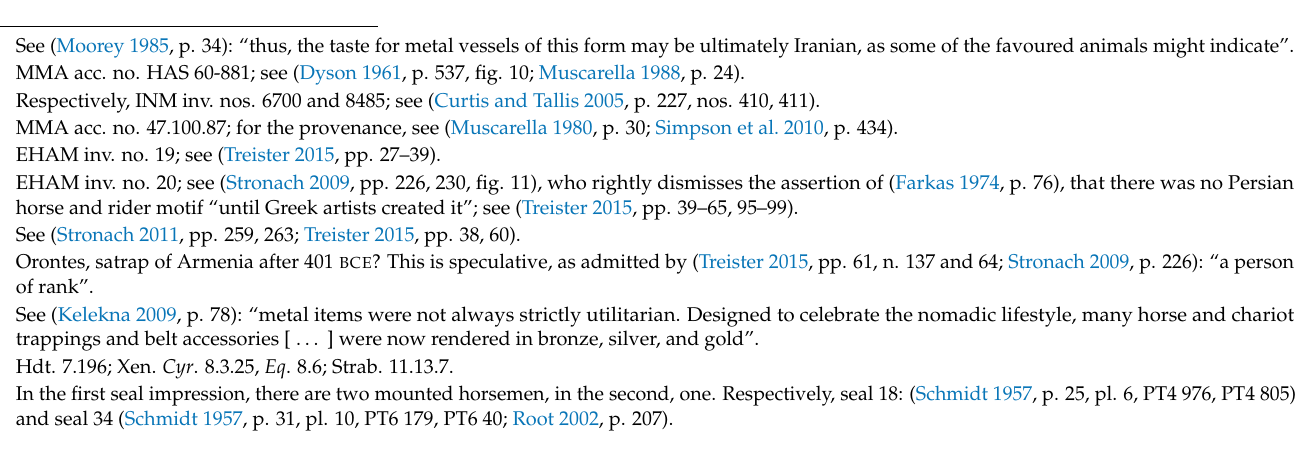
Figure 7. Drinking vessel in shape of horse protome (EHAM inv. no. 19); rhyton, silver; Erebuni, Armenia; (post?) Achaemenid, ca. 4th cent. BCE [image courtesy of the Erebuni Historical and Ar- chaeological Museum-Reserve, Yerevan]. Figure 8. Drinking vessel in shape of horse with rider (EHAM inv. no. 20); rhyton, silver; Erebuni, Armenia; (post?) Achaemenid, ca. 4th cent. BCE [image courtesy of the Erebuni Historical and Ar- chaeological Museum-Reserve, Yerevan].